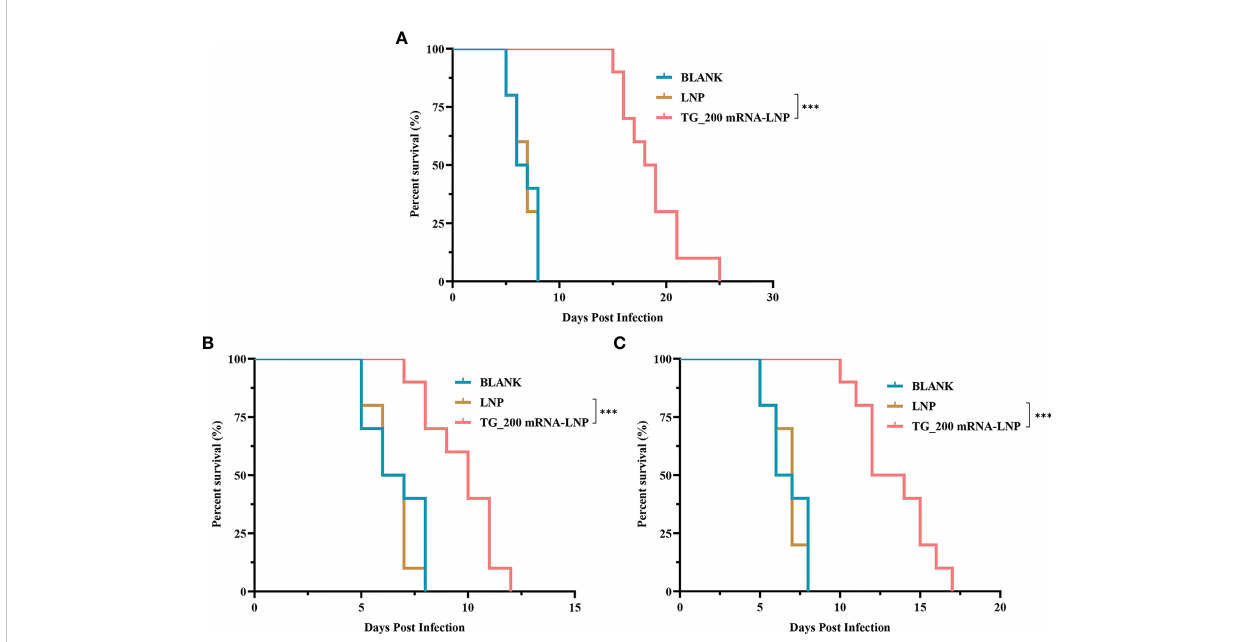
FIGURE 9 The survival rate of mice immunized with TG_200 mRNA-LNP and adoptively transferred serum or splenocytes from vaccinated mice. (A) The survival rate of BALB/c mice immunized with TG_200 mRNA-LNP, LNP and BLANK group and challenged with 1×10 2 T. gondii RH tachyzoites two weeks after the last immunization, n = 10/group. (B) The survival rate of mice receiving adoptively transferred serum (daily for fi ve days) from mice vaccinated with TG_200 mRNA-LNP, LNP and BLANK group and challenged with 1×10 2 T. gondii RH tachyzoites, n = 10/group. (C) The survival rate of mice receiving adoptively transferred splenocytes (5×10 7 ) from mice vaccinated with TG_200 mRNA-LNP, LNP and BLANK group and challenged with 1×10 2 T. gondii RH tachyzoites, n = 10/group. ***P< 0.001.